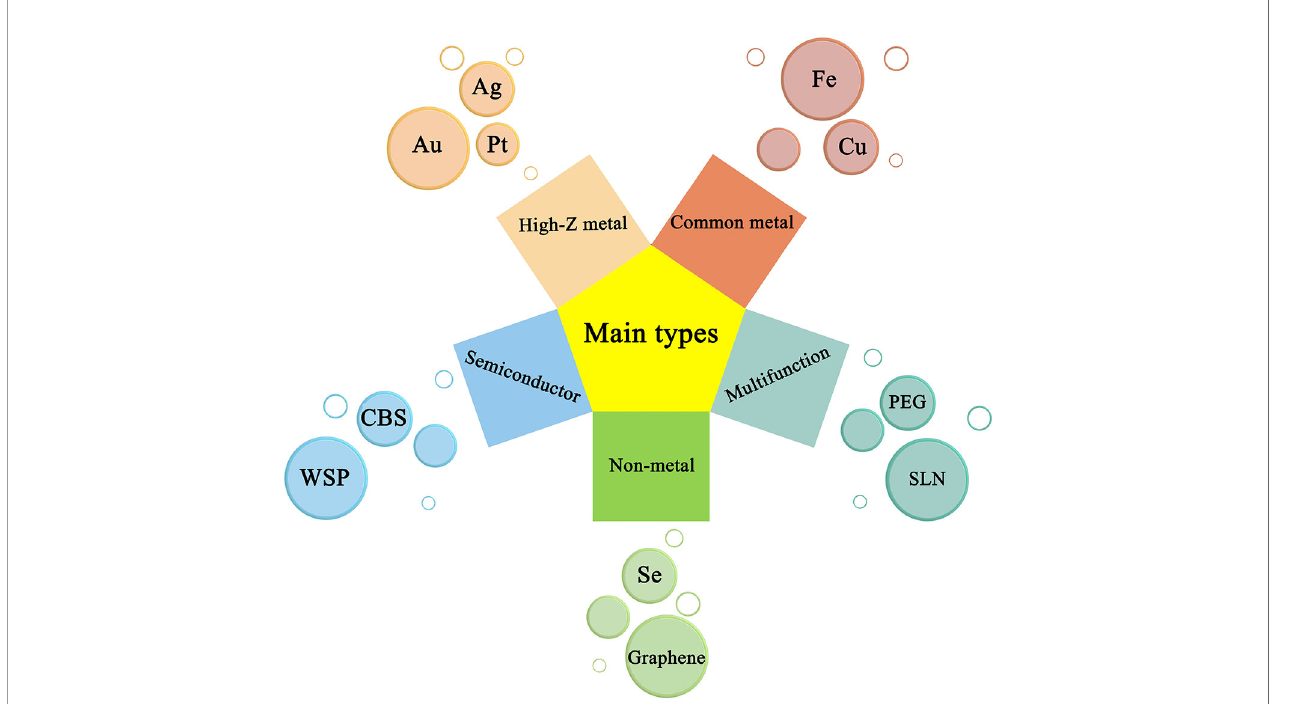
FIGURE 5 | Representative nanomaterials and basic principles of action under types of